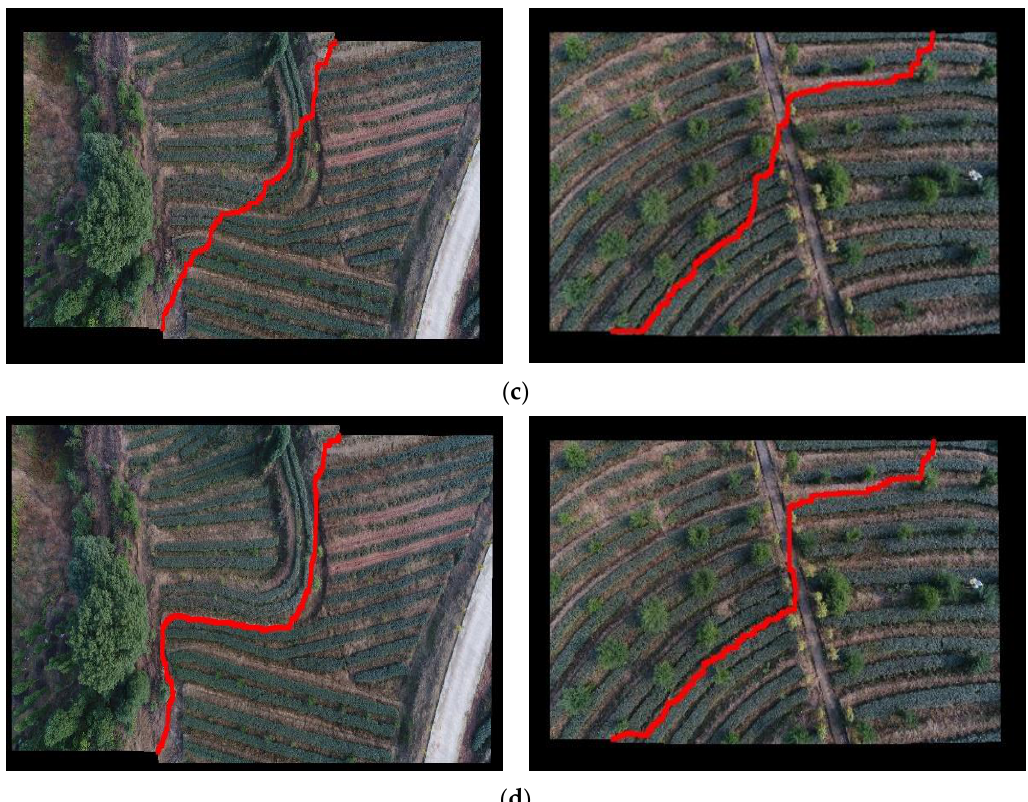
Figure 9. Results of the suture lines with different energy functions ( a ) based on the “color” fea- ture, ( b ) “gradient” feature, and ( c ) “color + gradient” feature ( d ) in this study. As shown in the above figures, the bold, red, solid lines are used to display the su-